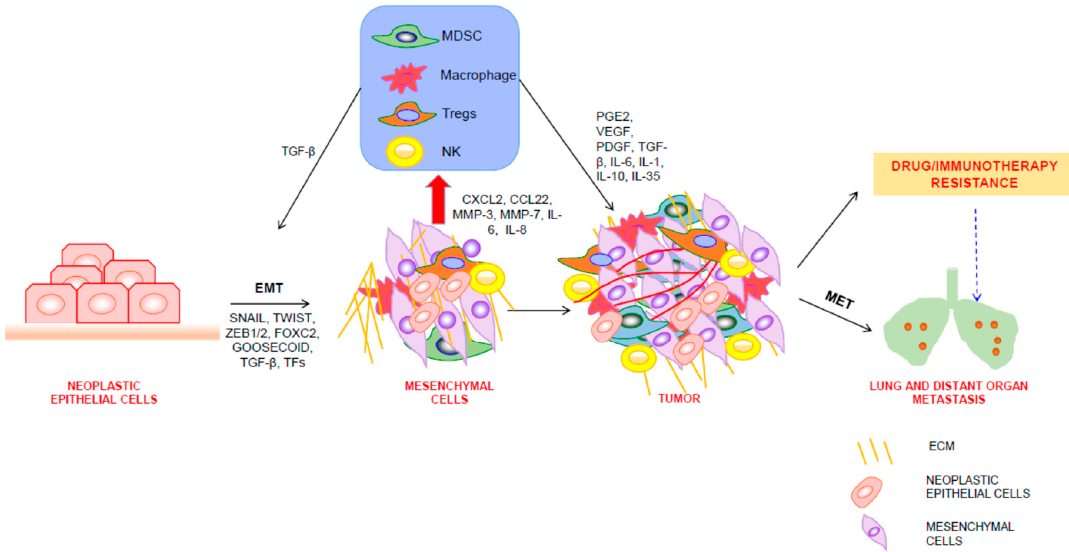
Figure 1. EMT, TME, and therapy. Neoplastic mammary epithelial cells undergoing transcriptional changes in key genes involved in EMT are transformed into mesenchymal cells. These mesenchymal cells secrete extracellular factors responsible for recruitment of immune cells and modulation of ECM. Recruited immune cells provide a proinflammatory milieu for growth of tumors by further secreting growth-promoting and prometastatic cytokines.